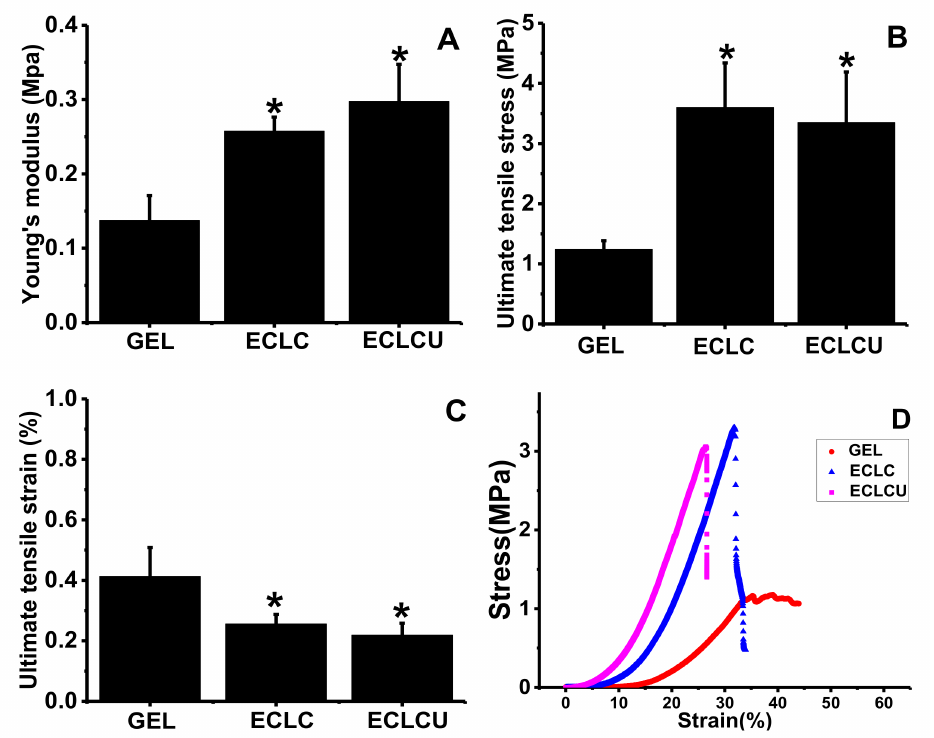
Figure 4. Tensile properties of GEL, ECLC and ECLCU. ( A ) Tensile modulus; ( B ) Ultimate tensile stress; ( C ) Ultimate tensile strain; ( D ) Stress-strain curve (* indicates significant difference compared with GEL at p <